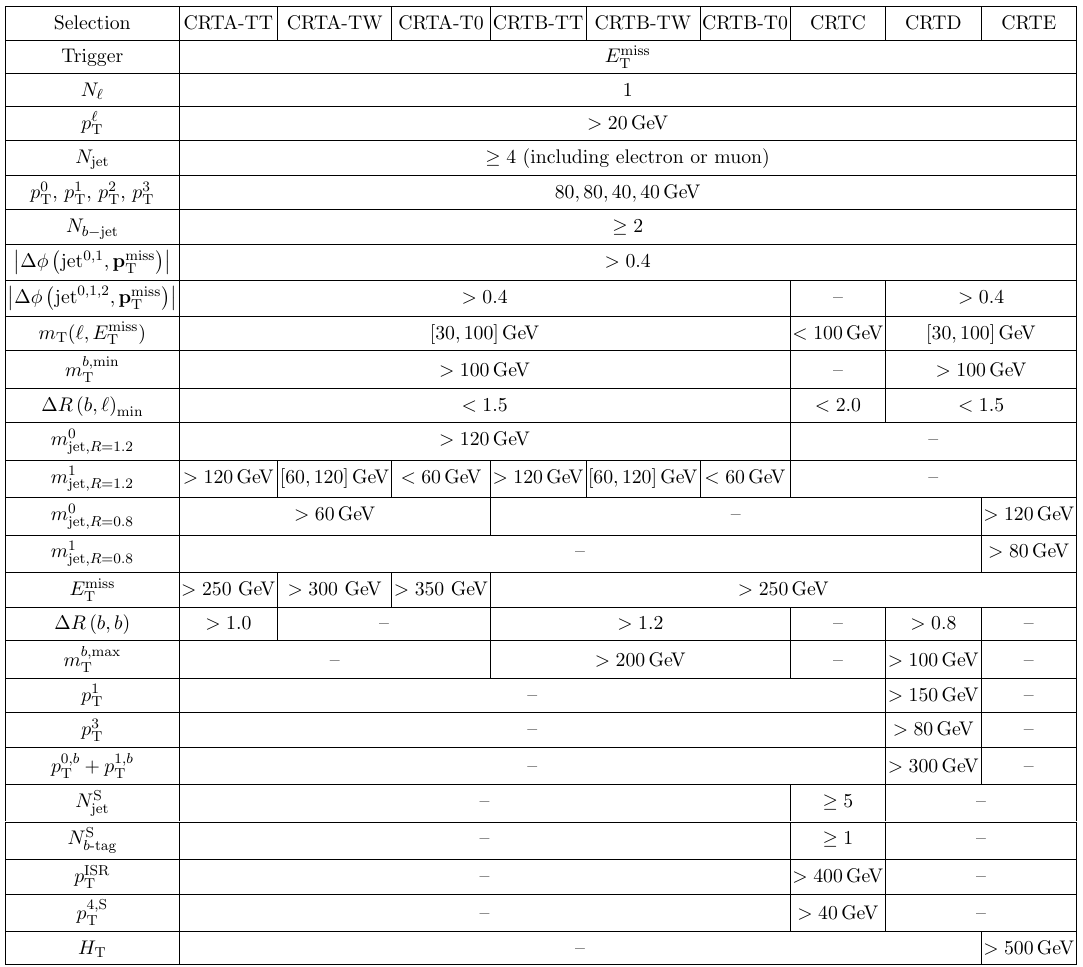
Table 6. Selection criteria for the t (cid:22) t control regions used to estimate the t (cid:22) t background contribu- tions in the signal